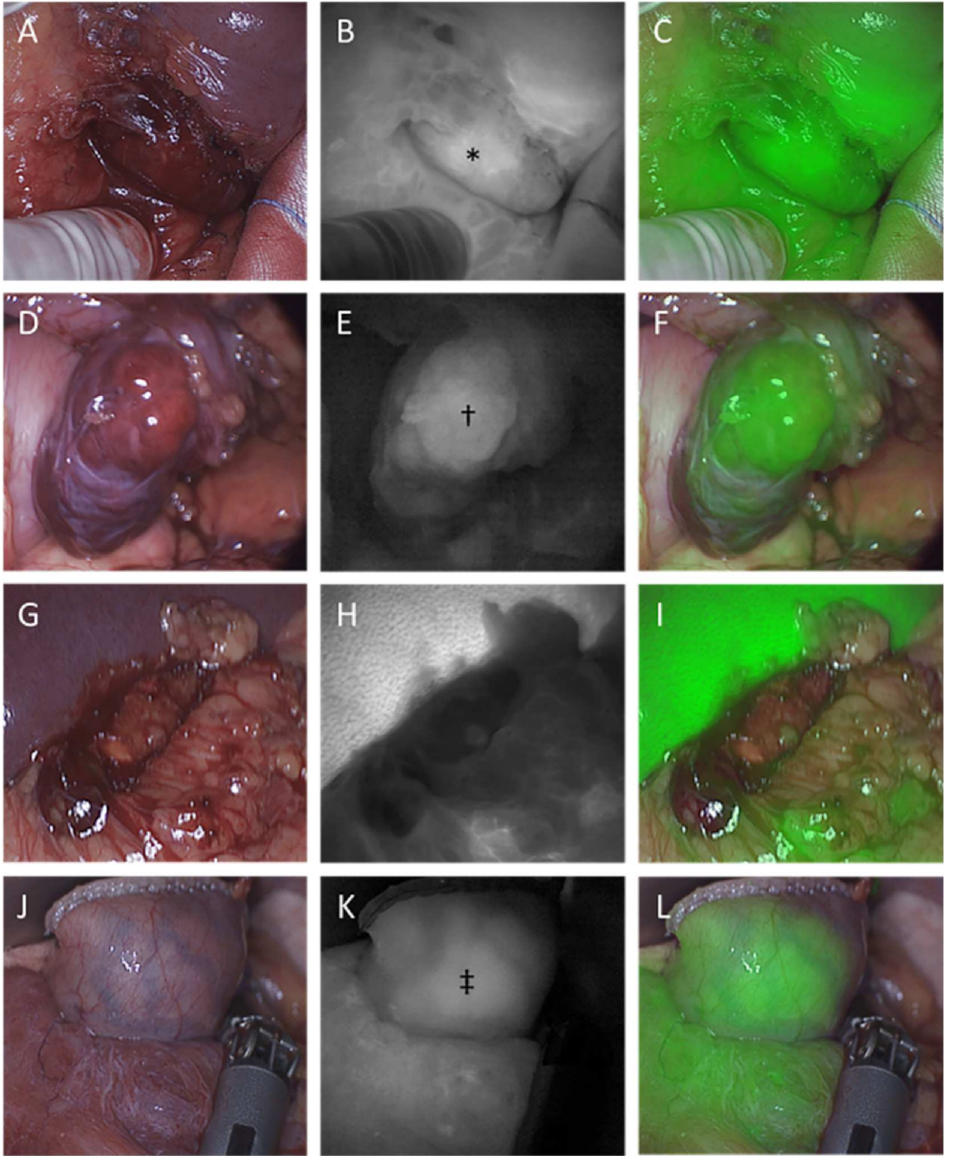
Figure 1. Imaging of 4 cases representing examples of all 4 scenarios described in the qualitative analysis results section, at 10 min after ICG administration. ( A , D , G , J ) Intraoperative white-light images. ( B , E , H , K ) Corresponding NIRF images. ( C , F , I , L ) Corresponding fused images. ( A – C ) Patient 6. An exophytic GIST arising from the duodenum, after imatinib treatment. The fluorescence in the lesion is similar to that in the surrounding tissue. * A hyperfluorescent region within the diffusely fluorescent tumor, endorsing the biological tumor heterogeneity, possibly caused by the preoperative systemic treatment. The resected tumor was found to have 50% of tumor cells remaining. ( D – F ) Patient 1. An exophytic GIST arising from the stomach during laparoscopy, showing relatively high and specific fluorescence, and the highest TBR in the current study. † In particular, the central tumor bulk shows intense fluorescence. (G–I) Patient 8. An exophytic GIST arising from the stomach, showing close to no fluorescence, while intense fluorescence is observed in the adjacent liver tissue. The lowest TBRs were calculated in this GIST for every timepoint. (J–L) Patient 2. An intraluminal GIST of the stomach. The stomach shows diffuse fluorescence. ‡ A region of the stomach wall, at the tumor location, shows more intense fluorescence than the surrounding stomach tissue. Nevertheless, directly after resection, no specific tumor fluorescence could be observed in the resected